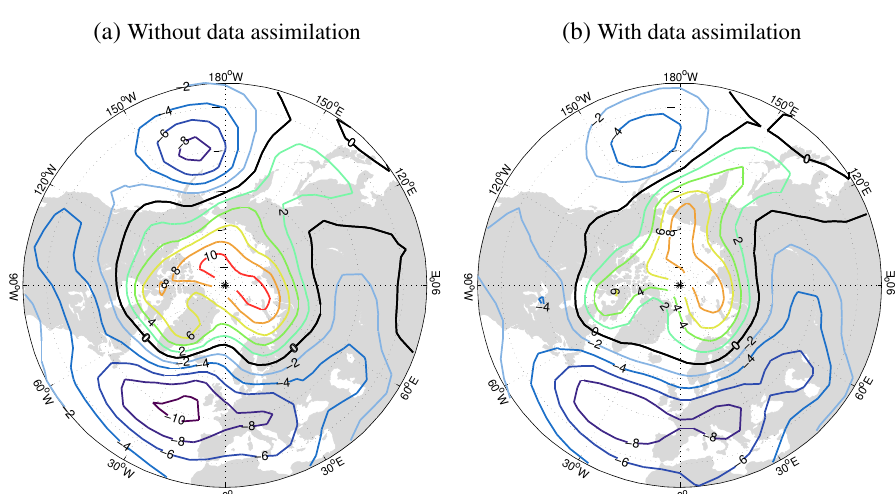
Figure 8. MH annual geopotential height anomalies (in m) at 800hPa simulated by (a) LOVECLIM without assimilation and (b) LOVECLIM with assimilation of sea ice proxy data. The reference period is AD1850–1900.